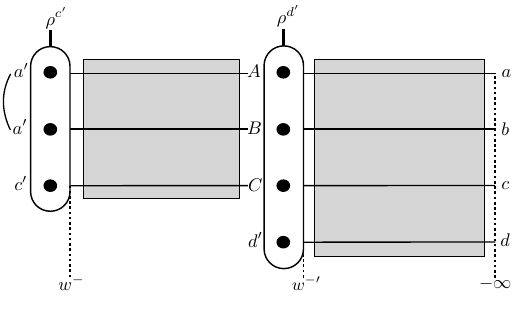
Figure 7 . Schematic representation of the connected correlator H 2 ; 4 factorized in eq. (B.19).